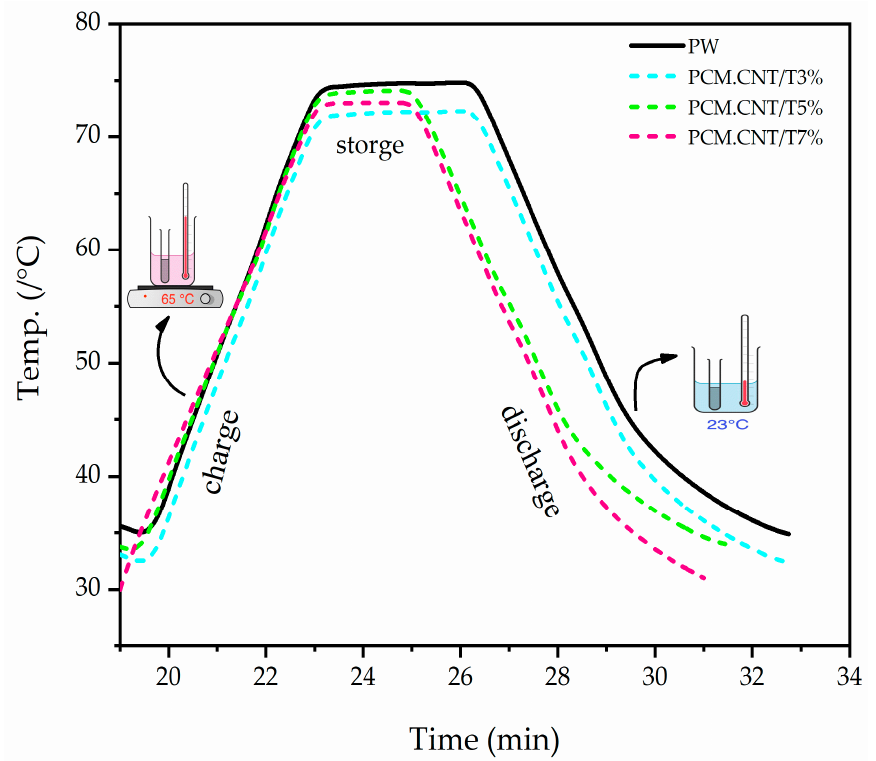
Figure 8. Time–temperature plot curves of latent heat storage and release storage for PW and com- posites.